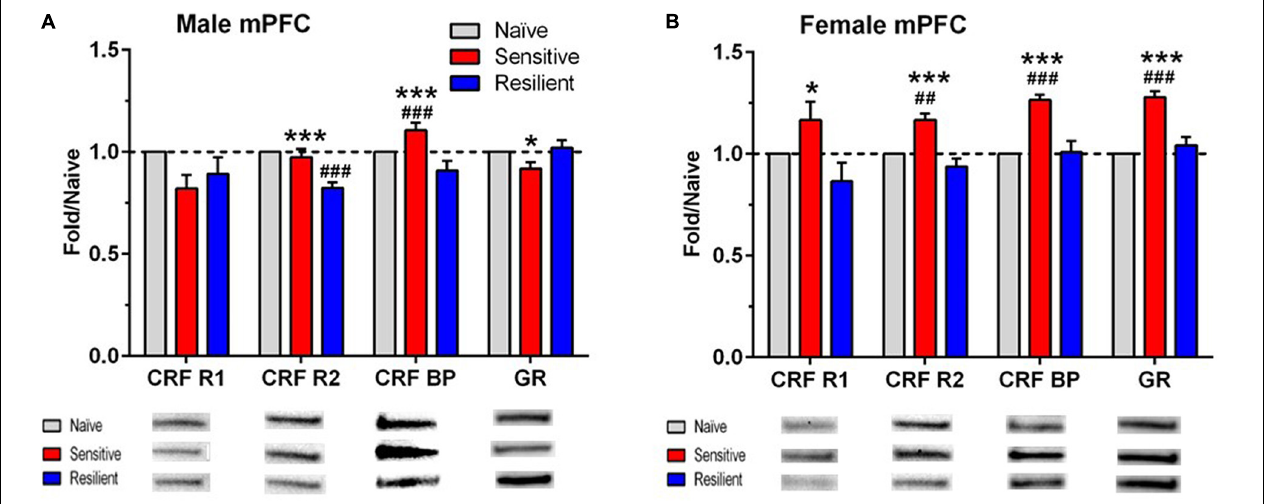
FIGURE 5 | Sex- and subgroup-dependent changes in protein levels related to stress-regulating systems in the medial prefrontal cortex (mPFC) after a history of ethanol drinking and intermittent predator stress exposure. There were divergent, treatment- and subgroup-induced alterations in the proteins examined, with sex differences observed for CRF-R1, CRF-R2, and GR. Representative animals from the “sensitive” and “resilient” subgroups depicted in Figures 2 , 3 were chosen for the Western blot analyses, and values were compared to separate groups of naïve mice. Values are mean ± SEM levels that were normalized to β -actin and then normalized to the respective naïve group (dashed line) for male (A) and female (B) mice. Changes in relative protein levels were compared using normalized optical density measurements. Representative bands from the immunoblots for each protein are included beneath each panel on the graph. Representative immunoblots for each protein, brain region, and sex are depicted in Supplementary Figures 1–4 . Group size: naïve (10–11 male, 8–10 female), “sensitive” subgroup (7 male, 5 female), “resilient” subgroup (10 males, 8 females). * p ≤ 0.05, *** p ≤ 0.001 vs. respective “resilient” subgroup; ## p ≤ 0.01, ### p ≤ 0.001 vs. respective naïve. The results depicted reflect either separate analyses for each sex (CRF R1, CRF R2, GR) or analyses with the sexes combined (CRF BP). See Table 2 for ANOVAs. CRF R1, corticotropin releasing factor receptor 1; CRF R2, corticotropin releasing factor receptor 2; CRF BP, corticotropin releasing factor binding protein; GR, glucocorticoid receptor.